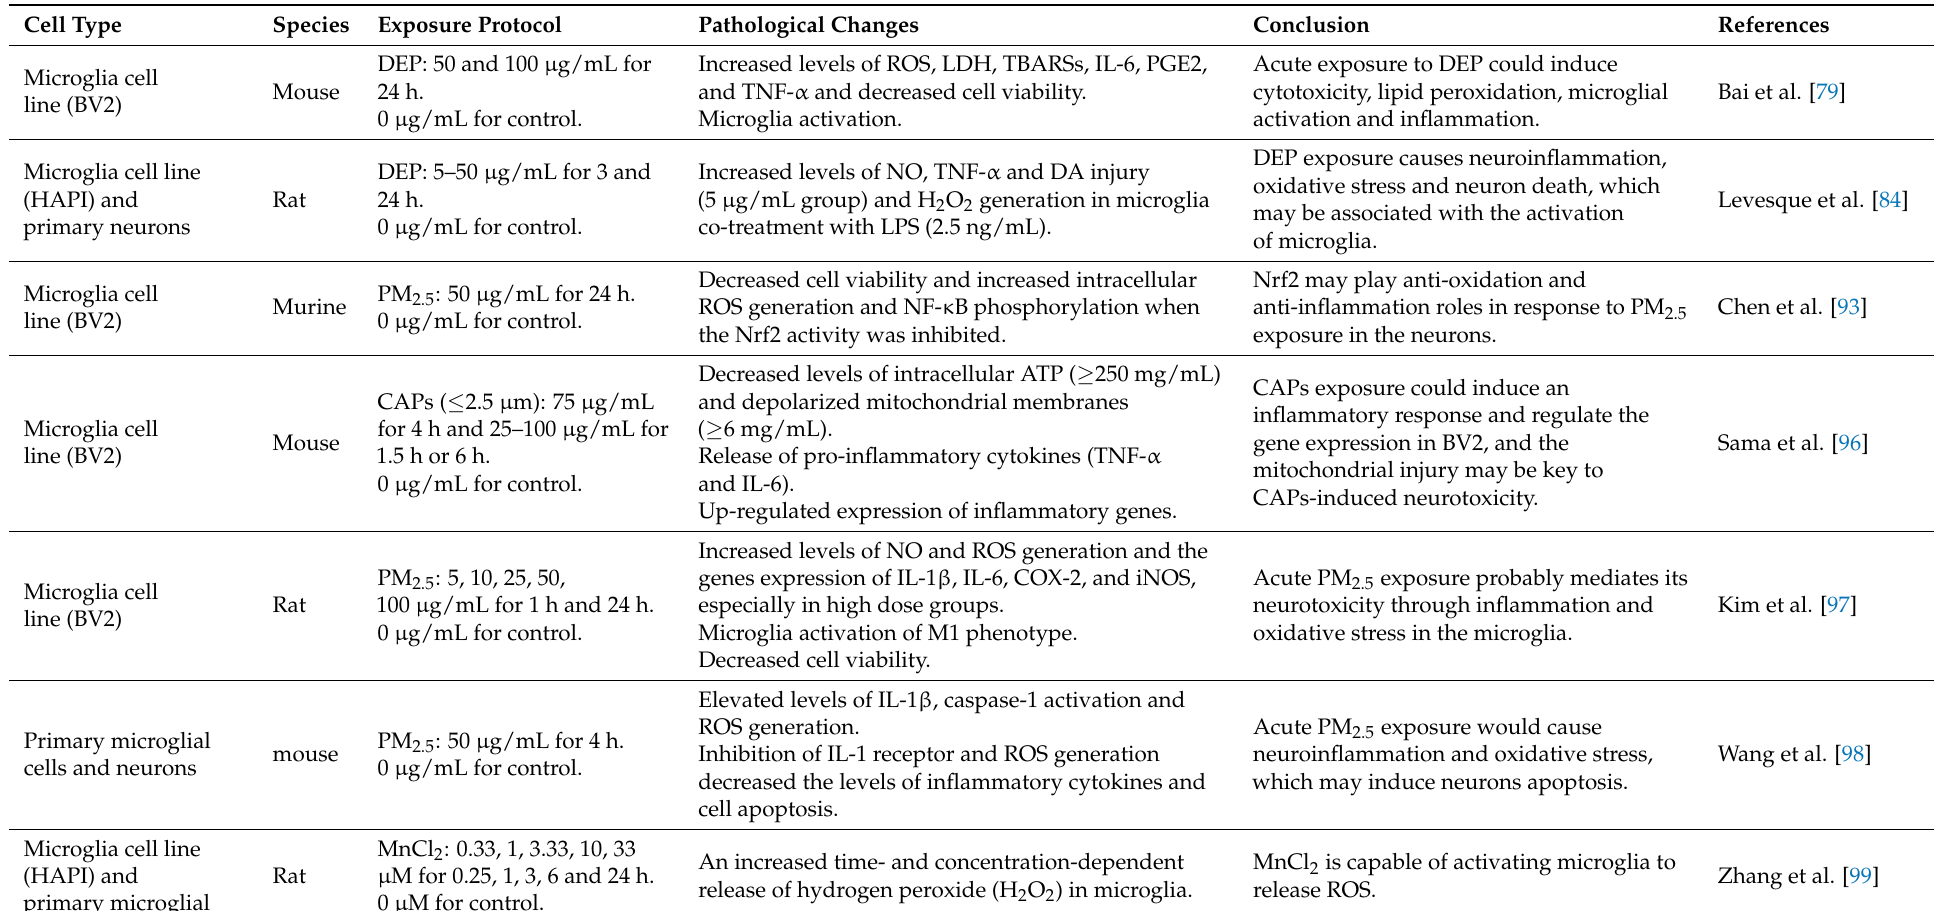
Table 3. Evidence from main in vitro studies with PM 2.5